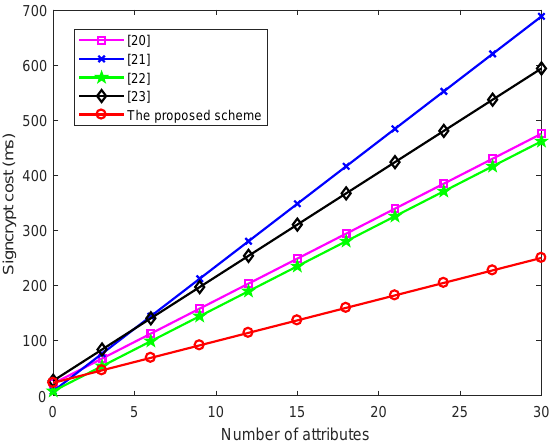
Figure 4. Signcrypt cost with the number of attributes.